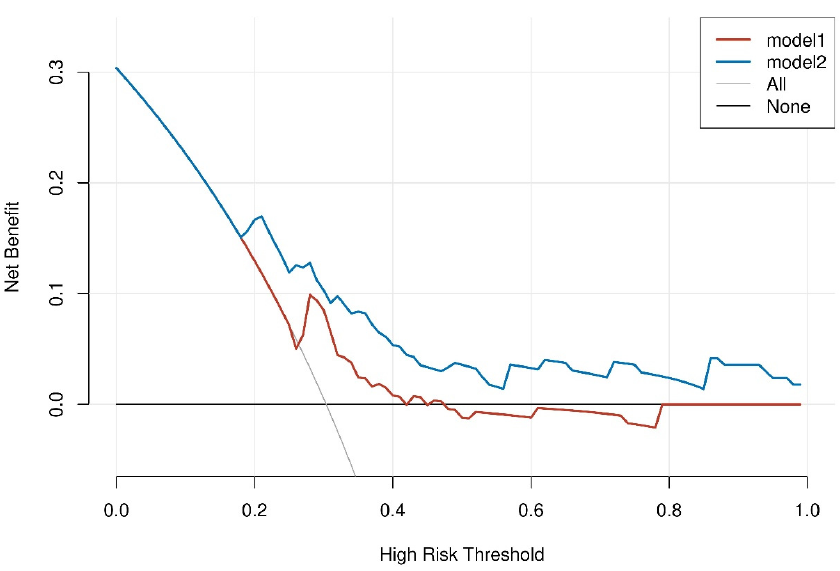
Figure 3. The threshold probability and net benefit are represented by the DCA curve’s horizontal and vertical coordinates, respectively. The graph contains four different sorts of lines: INHB/AMH (model1) is represented by the blue line, INHB (model 2) is represented by the dashed red line, and the two ex- treme examples are represented by the solid gray and black lines. The solid gray line on the horizontal one shows that all samples were negative, no one intervened, and there was no net benefit.